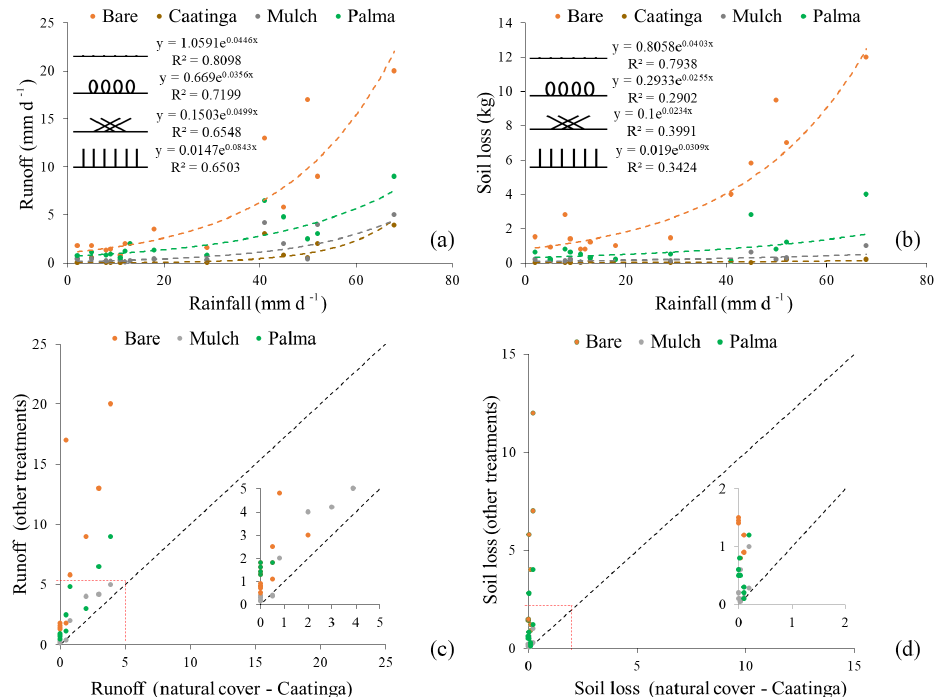
Figure 9. (a, b) Rainfall-runoff and rainfall-soil loss relationships for the different cover conditions. (c, d) Comparison of runoff and soil loss of different cover conditions with